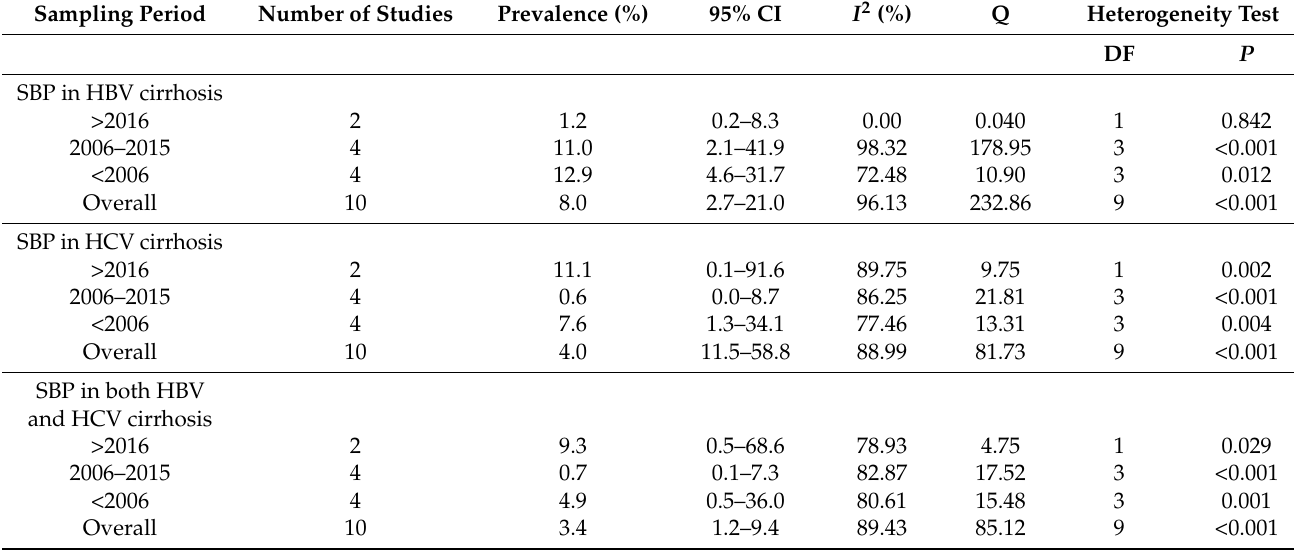
Table 4. Subgroup analysis of SBP in three different viral hepatitis-related liver cirrhosis with the year of sampling.